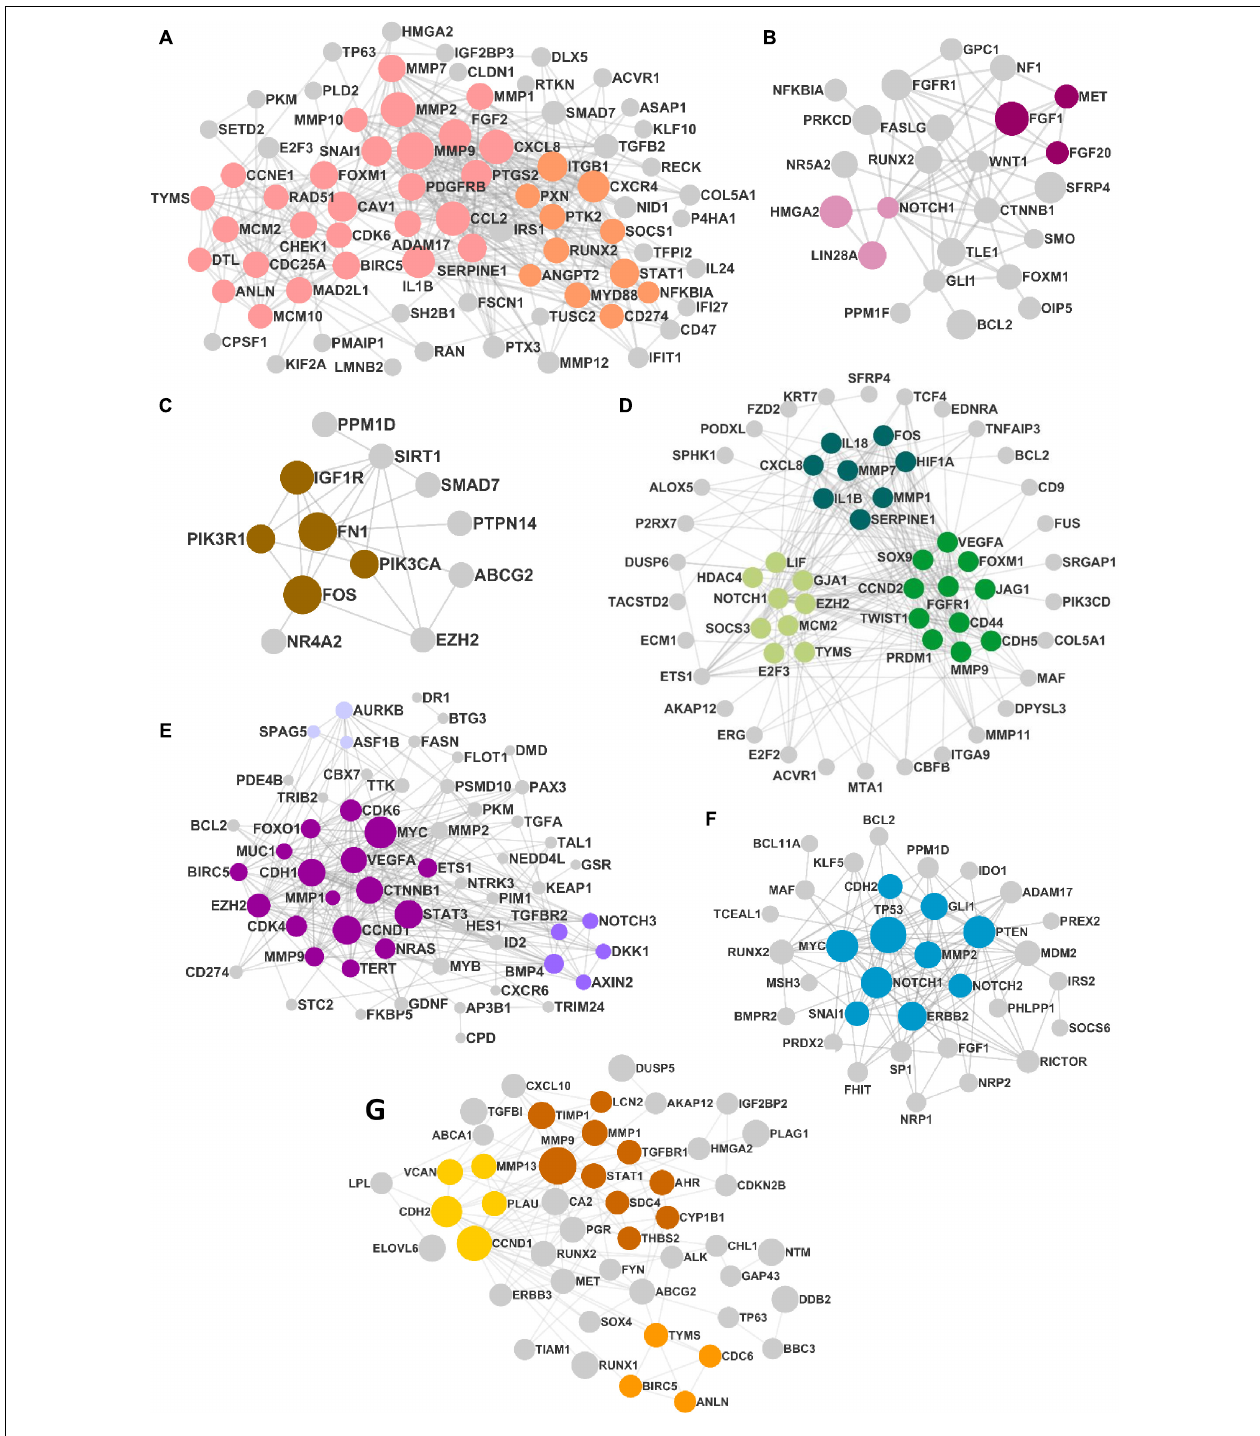
FIGURE 3 | The protein–protein interaction network (PPIN) in (A) head and neck squamous cell carcinoma (HNSCC), (B) breast cancer, (C) pancreatic cancer, (D) gastric cancer, (E) liver cancer, (F) lung cancer, and (G) thyroid cancer. The size of the nodes is distributed according to the number of in and out degrees.